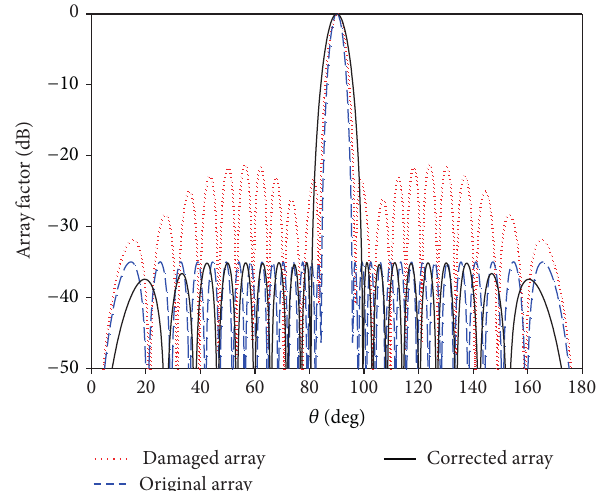
Figure 7: The damaged, original, and corrected radiation